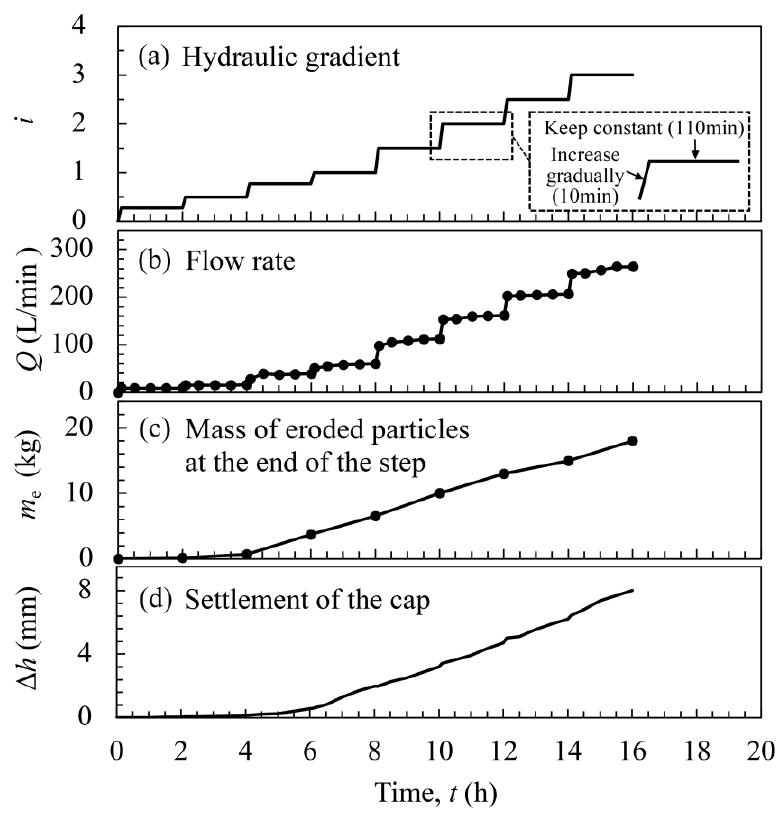
Figure 5. The imposed hydraulic gradient and typical measurements in the test: ( a ) the imposed stepwise increasing hydraulic gradient; ( b ) the typical recorded flow rate; ( c ) the typical recorded mass of eroded particles at the end of the step; ( d ) the typical recorded settlement of the cap. (The specimen of dangerous gradation under σ v = 1.0 MPa was taken as an